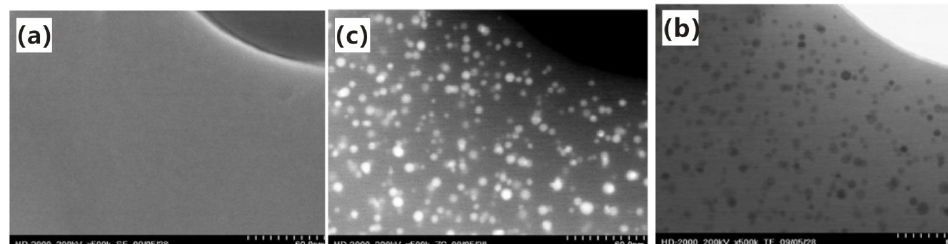
Figure 12. ( a ) SEM; ( b ) bright-field TEM, and ( c ) dark-field TEM images of Au/SBA-15 and ( d ) its activity in CO oxidation (1% CO, balance air, flow rate: 37 mL min − 1 ).